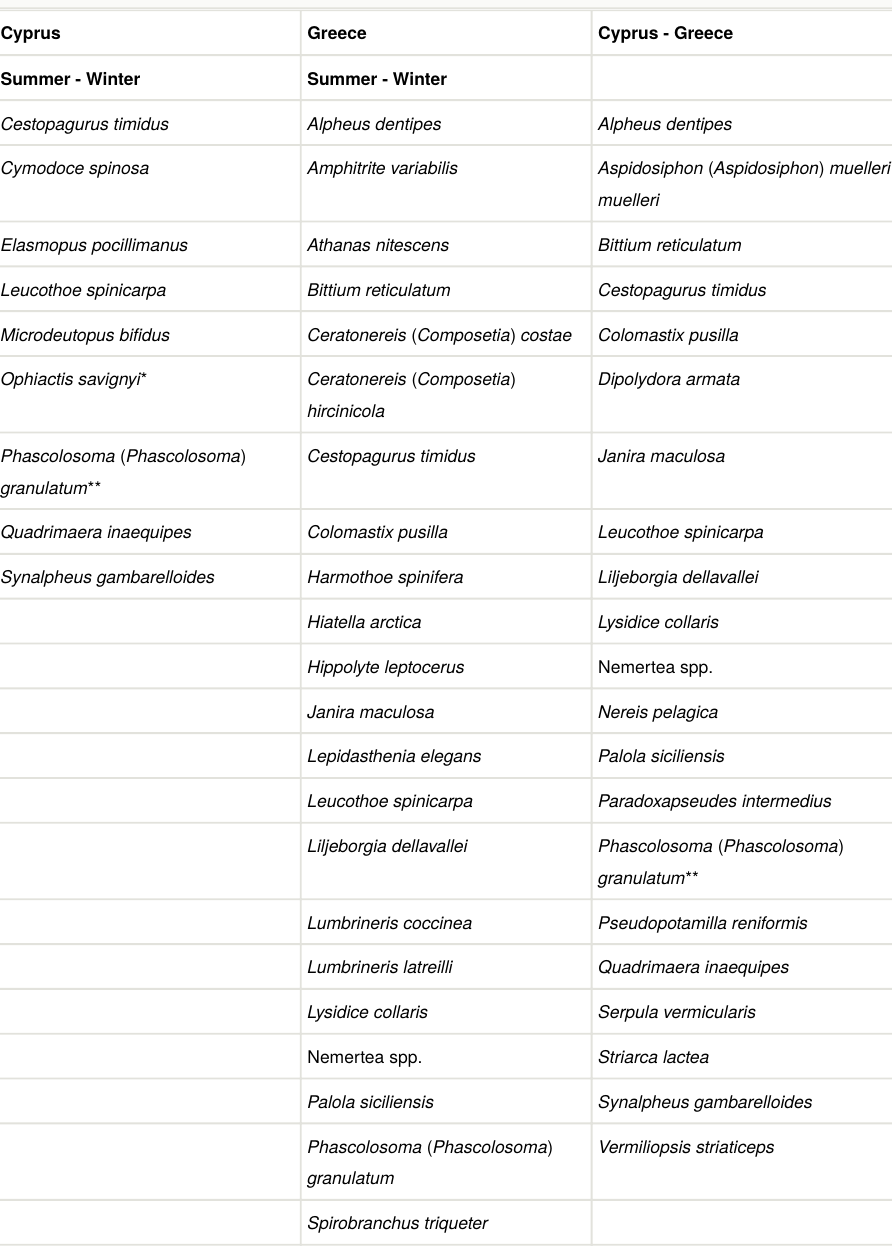
Table 3. Species found in common between the samples. *: non-indigenous species (ÖZTOPRAK et al. 2014, Pancucci-Papadopoulou et al. 2005). **: identi fi cation questionable for individuals from Cyprus (may be in fact Phascolosoma ( Phascolosoma ) stephensoni )